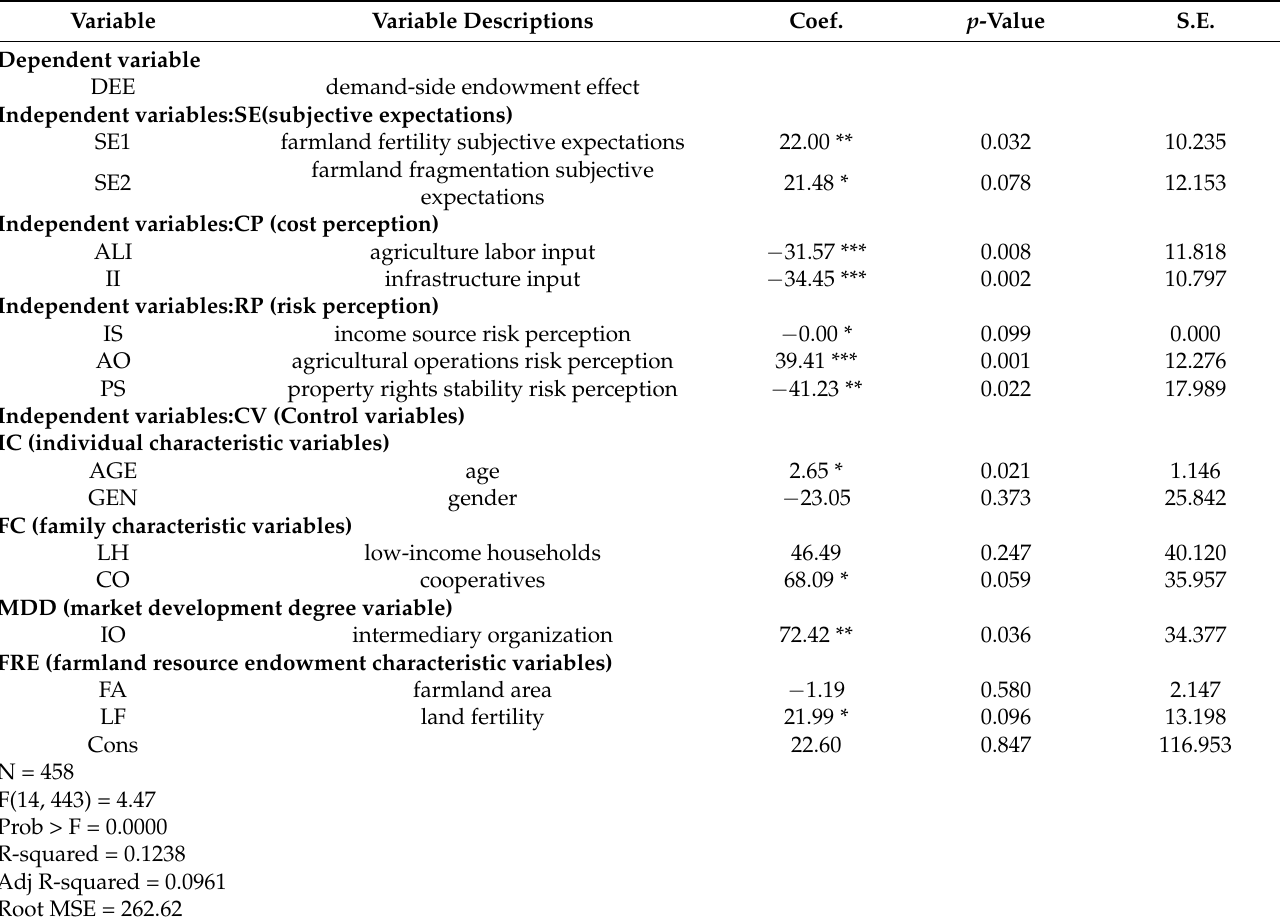
Table 6. Estimation results of the influence of the demand-side endowment effect based on the multiple regression